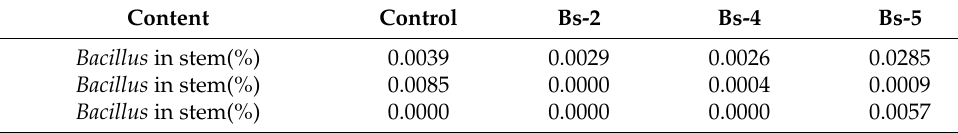
Table A2. Saprophytic Bacillus effected on the stem of Aquilaria sinensis .